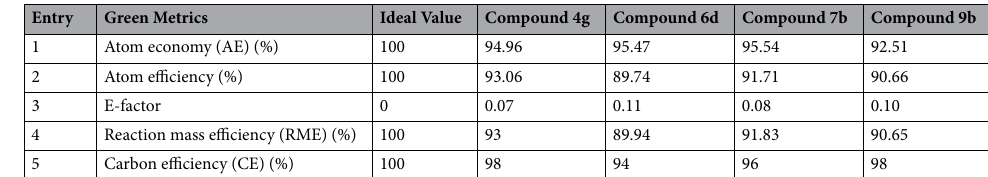
Table 7. Green metrics calculation for compounds 4g , 6d , 7b , and 9b